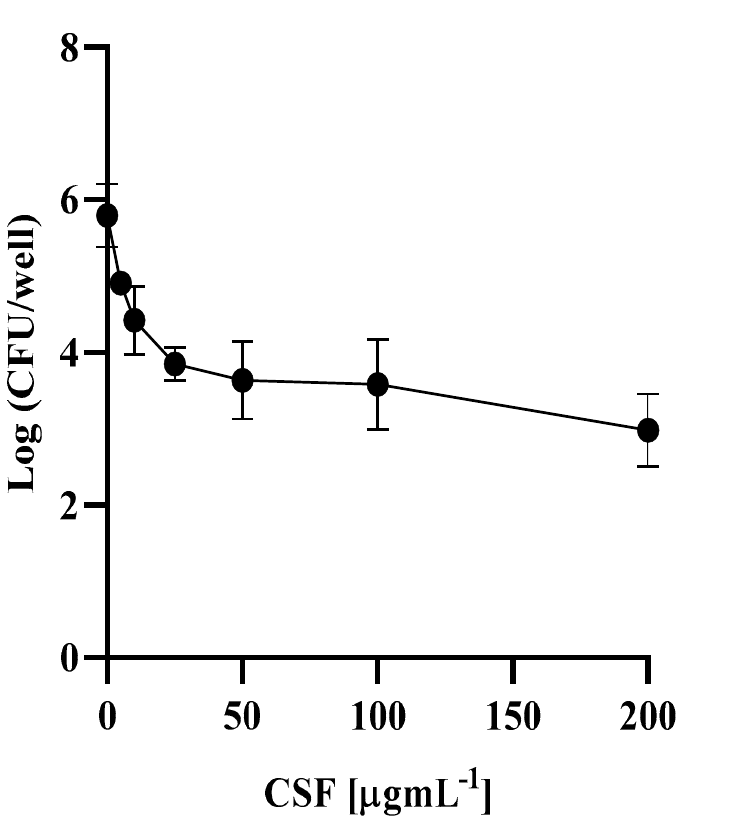
Figure 2. Detection of persisters in Candida auris biofilm: survival of C. auris cells in biofilm following treatment with caspofungin (CSF) at different concentrations. Data are the mean of three independent experiments ± SD.